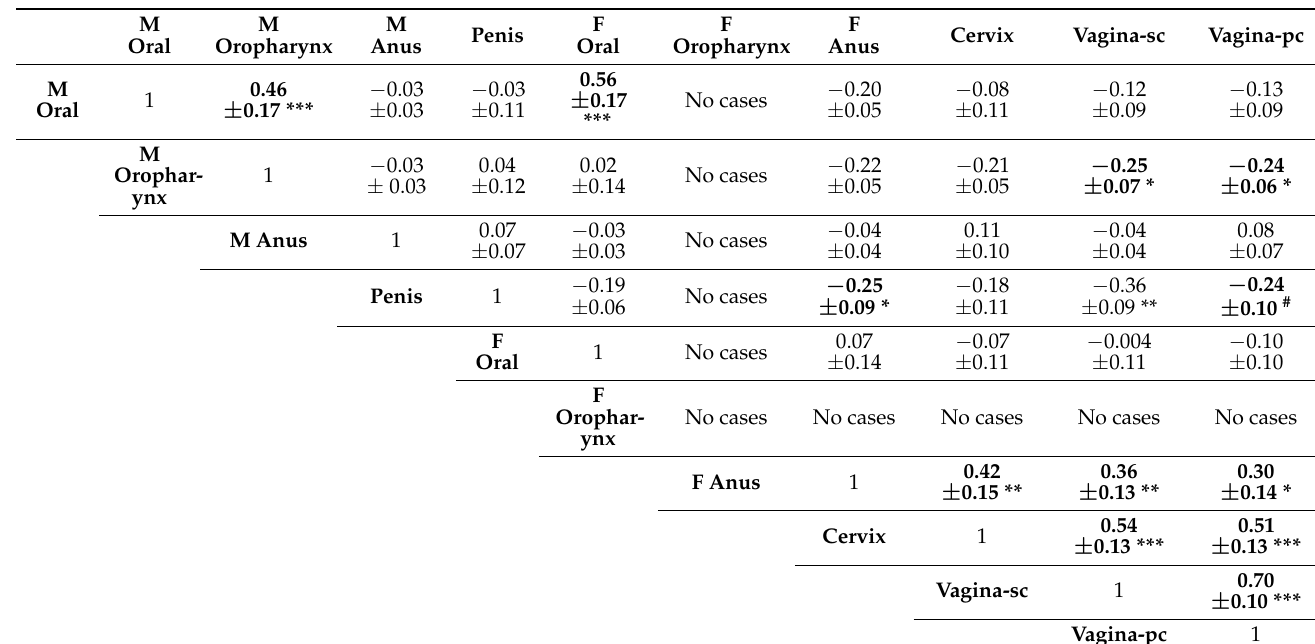
Table 4. Concordances ( κ ) between mucous membranes and